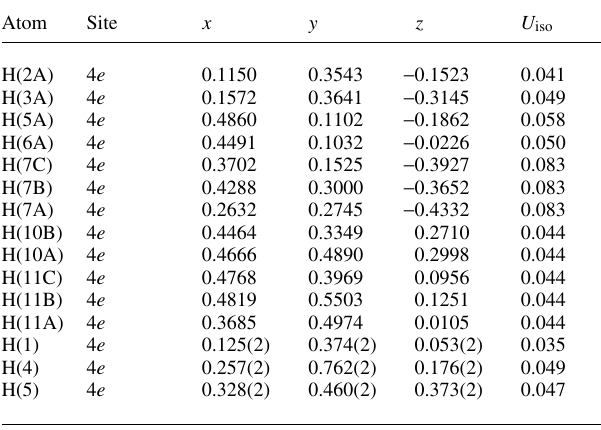
Table 2. Atomic coordinates and displacement parameters (in Å 2 )